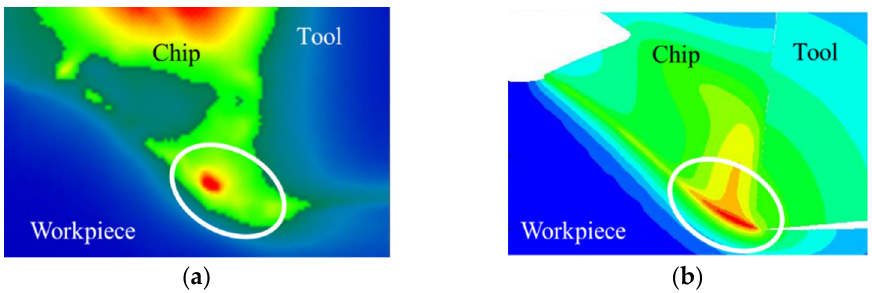
Figure 12. Experimental ( a ) and simulated ( b ) thermal fields during orthogonal cutting of Ti6Al4V. V c = 7.5 m/min and f = 0.4 mm.